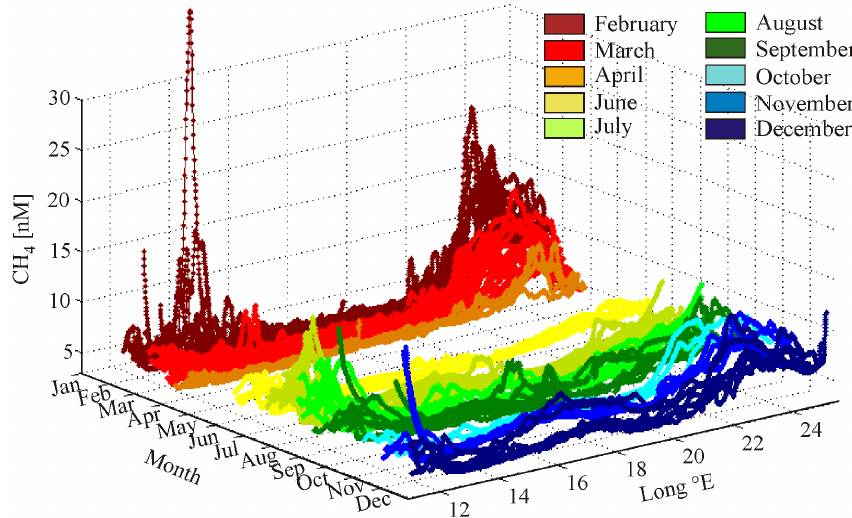
Fig. 2. Methane concentrations of all lines along transect I and II in 2010 color-coded for each month. During most of April and May no data could be gathered due to maintenance. Later gaps in the continuous data set are in part due to the passage of the ferry along the transect III.